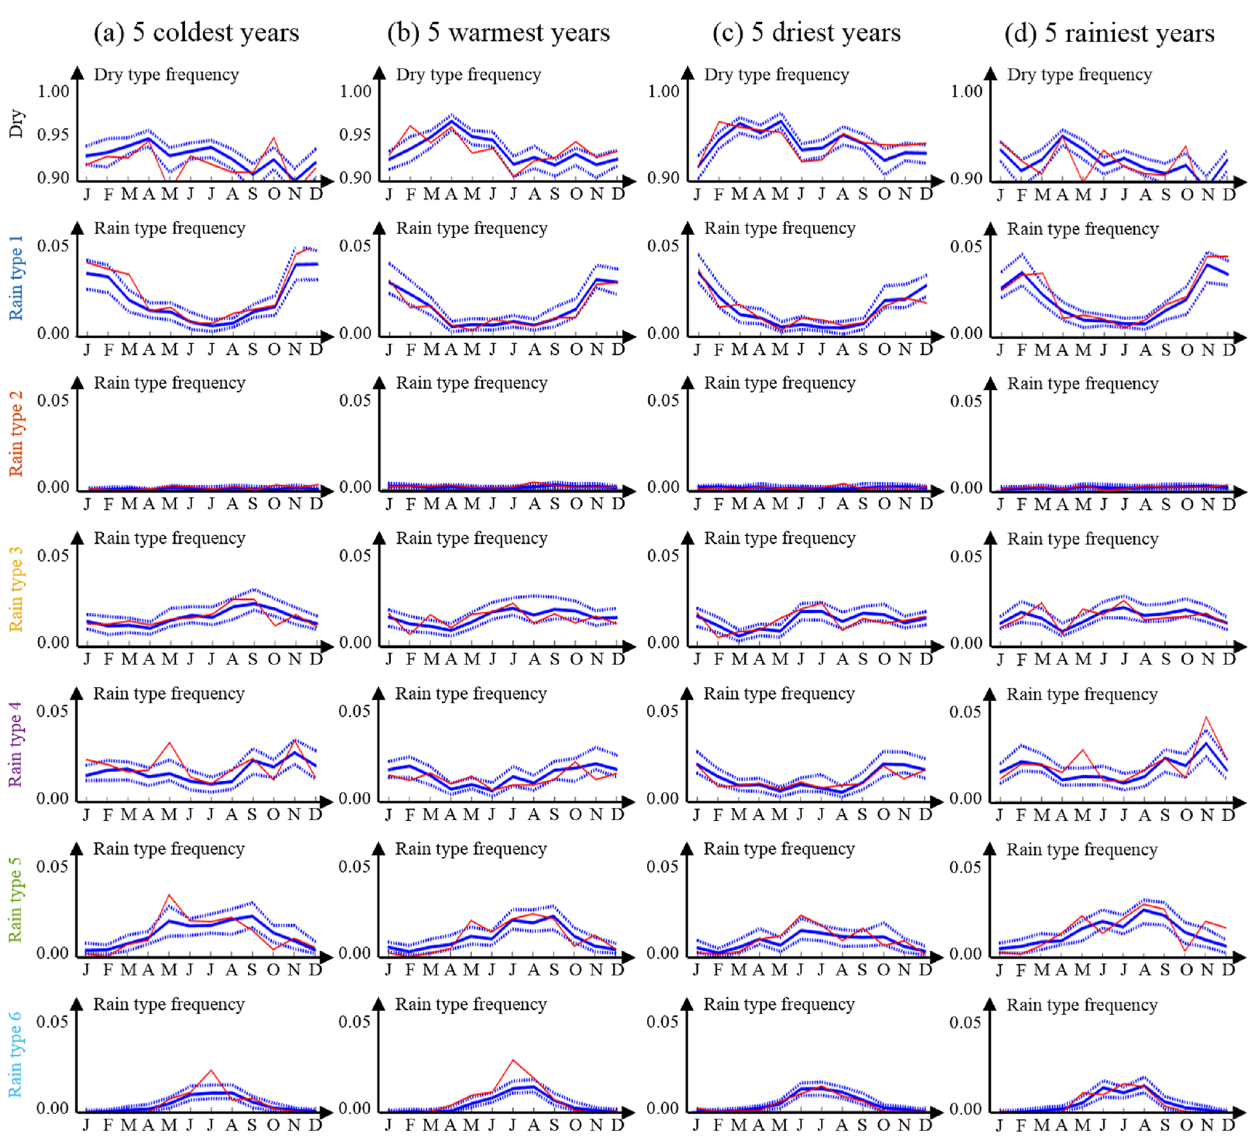
Figure 7. Monthly rain type occurrence stratified according to climate forcing: (a) 5 coldest years of the 2001–2017 period (2001, 2004, 2005, 2010 and 2013), (b) 5 warmest years (2007, 2011, 2014, 2015 and 2017), (c) 5 driest years (2003, 2011, 2012, 2015 and 2016) and (d) 5 wettest years (2001, 2002, 2007, 2009 and 2010). Observations are in red, and simulations are in blue. In simulations, continuous lines represent the median of the simulated ensembles (50 realizations), and dashed lines represent the Q 10 and Q 90